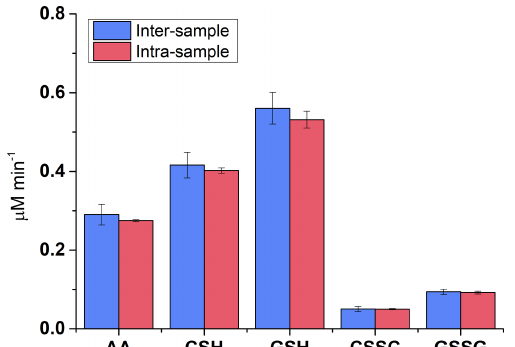
Figure 2. Depletion of antioxidants, AA, CSH, and GSH, and for- mation of oxidation products CSSC and GSSG in SELF-a con- taining 20µgmL − 1 of SRM and following an incubation time of 180min. Inter -sample reflects the reproducibility of the entire method ( n = 4), whereas intra -sample shows the post-incubation variability due to sample processing (from replicates of a single sample; n = 3).